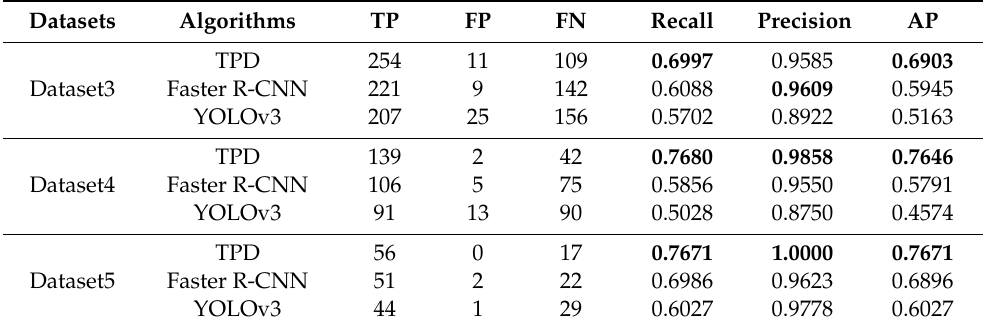
Table 4. The TP (true positive), FP (false positive), FN (false negative), AP (average precision) of TPD (tobacco plant detector), faster R-CNN (regions with CNN features) and YOLOv3 (you only look once v3).